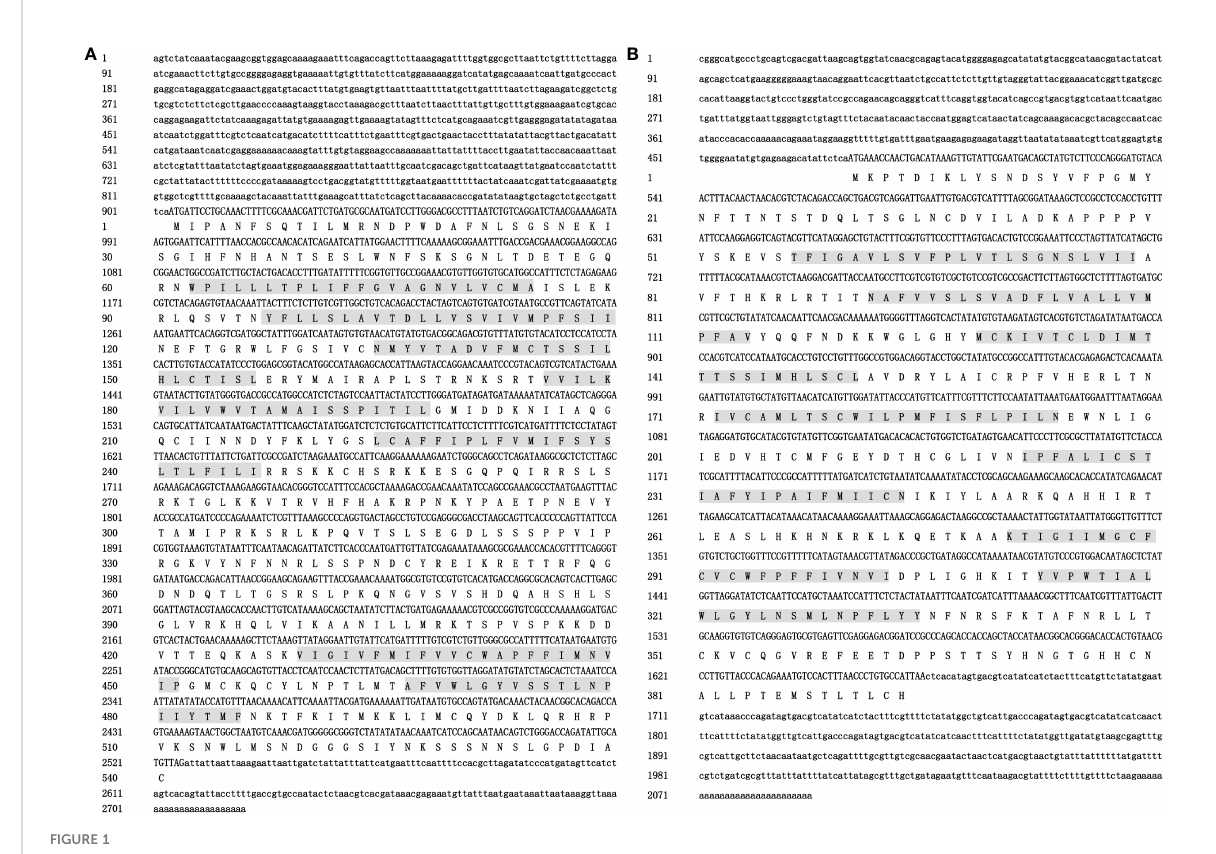
FIGURE 1 The nucleotide and deduced amino acid sequences of Pm5-HTR2 (A) and Pm5-HTR4 (B) . The 5 ′ -UTR and 3 ′ -UTR are indicated by small letters; capital letters represent the ORF and the deduced amino acid (aa) sequences; and the letters with gray background shows the transmembrane